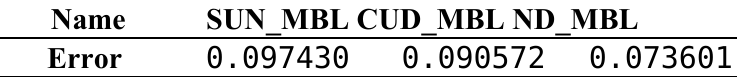
Table 2. The accuracy of different dynamic model.